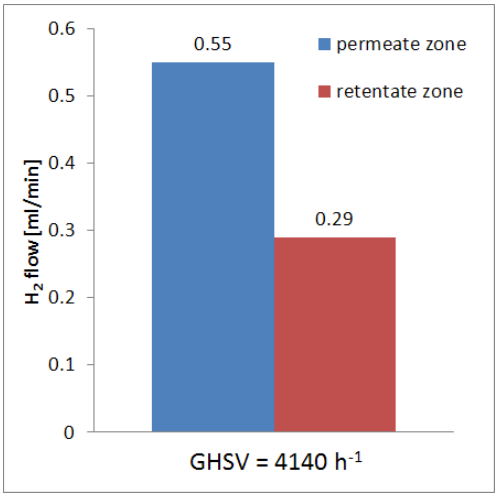
Figure 5. Hydrogen in the permeate and retentate streams during MSR reaction in the Pd ‐ Au MR at 420 °C, 300 kPa and GHSV = 4100 h − 1 . at 420 ˝ C, 300 kPa and GHSV = 4100 h ´ 1